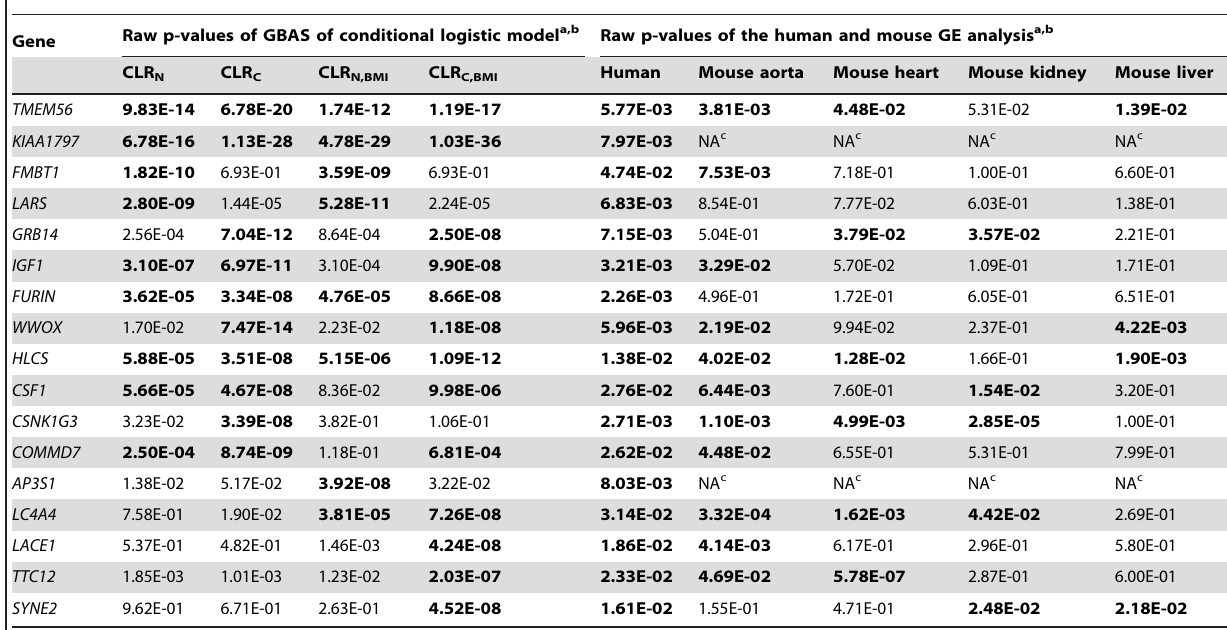
Table 2. Seventeen genes with differential allelic and transcriptional distributions identified by the TWNHS.